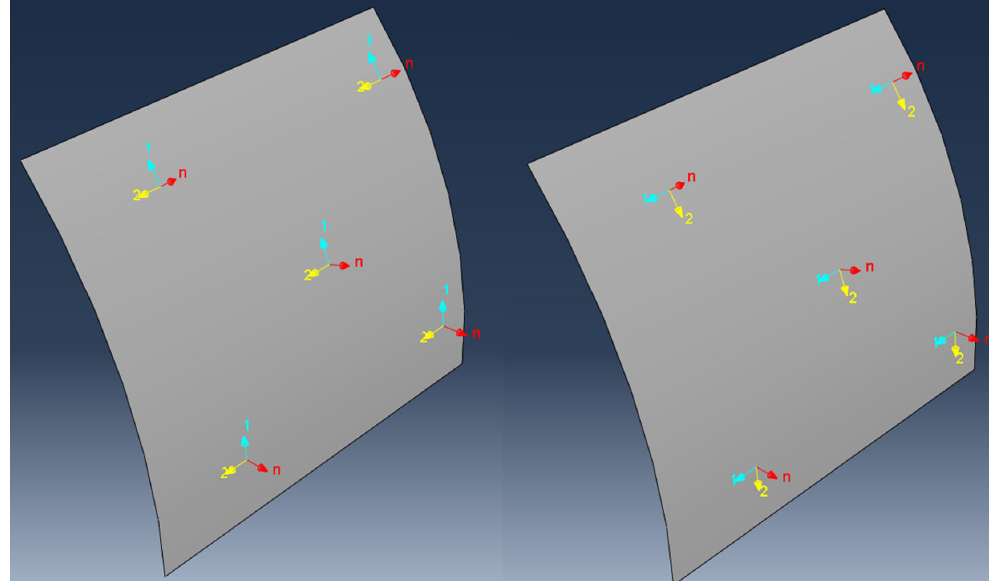
Figure 2. Definition of fiber layup direction. Table 1. Different FML structures parameter table.